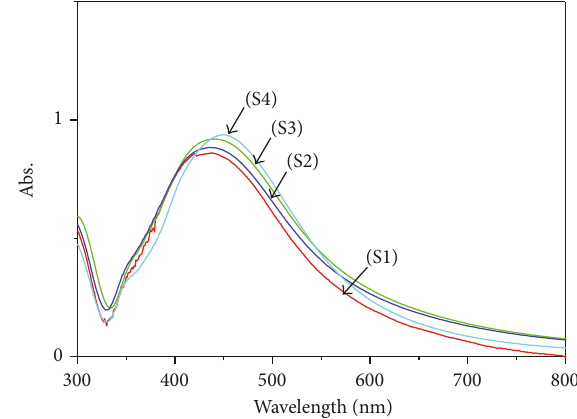
Figure 3: Optical absorption spectra of fluids containing Ag nanoparticles prepared at different MI